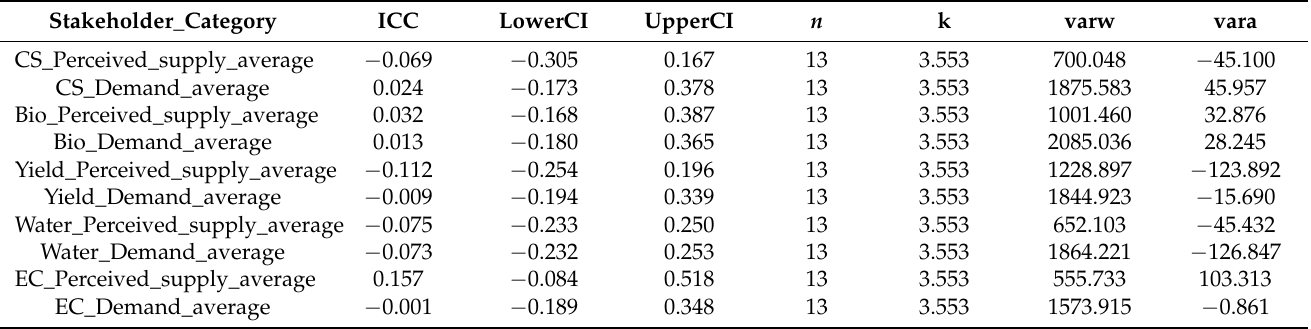
Table 3. Intraclass correlation coefficients and confidence interval estimation results between stakeholder categories and supply perceived and demands for ES (CS = carbon sequestration; Bio = biodiversity; EC = erosion control).